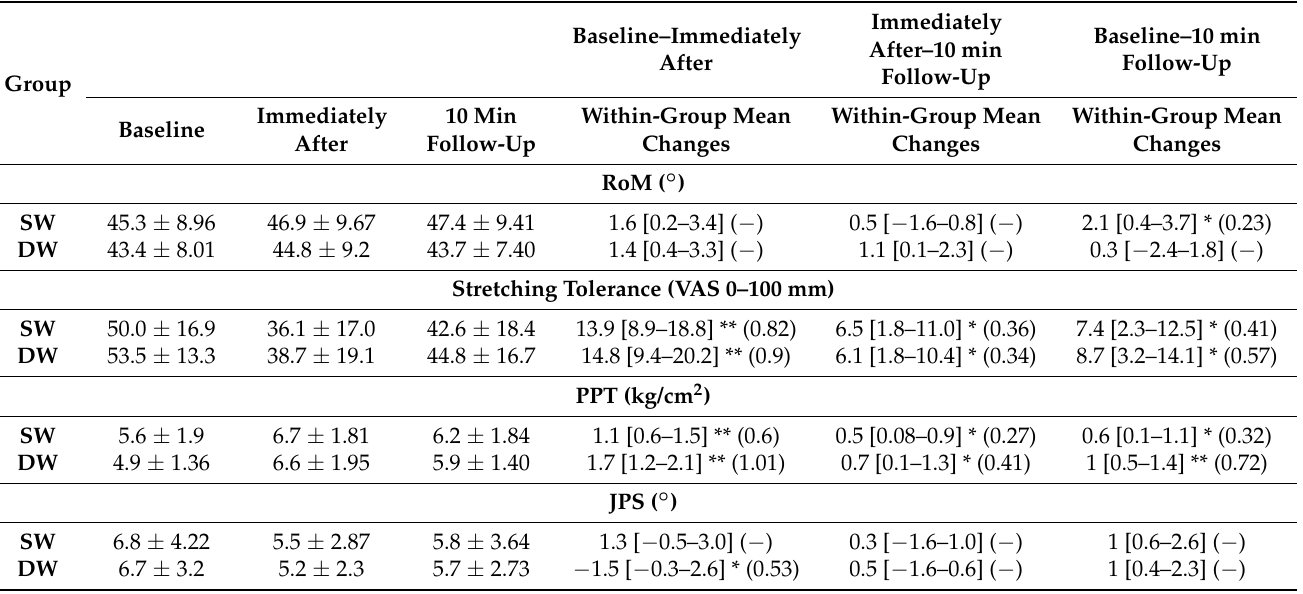
Table 2. Mean and standard deviation (SD) of static and dynamic warm-up interventions. Compar- isons within the groups at different